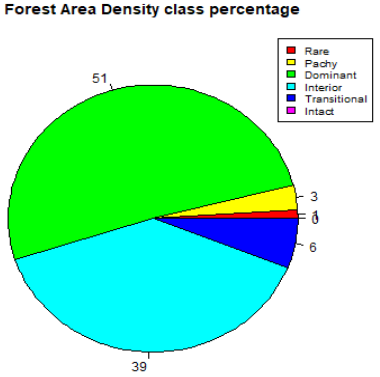
Figure 6. Forest area density (FAD) showing percentage of fragmentation class (2020). Table 8. Summary of observable scale for fragmentation analysis in the year 2020. Fragmentation